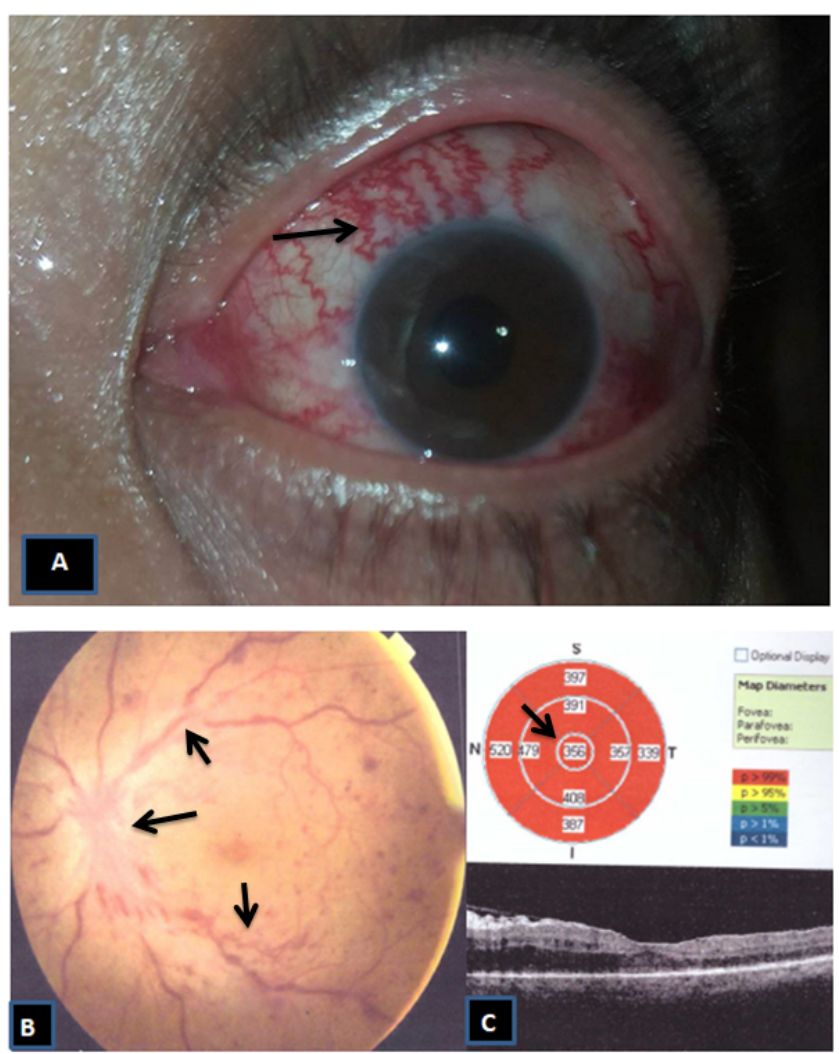
Figure 1: A) Conjunctival injection with corkscrew vessels and mild lid edema in the left eye. B) Picture of central retinal vein occlusion with dilatation of the retinal veins, scattered dot retinal hemorrhages and optic disc margin blurring in the left eye. C) Macular edema in the affected eye with central macular thickness (CMT) 356